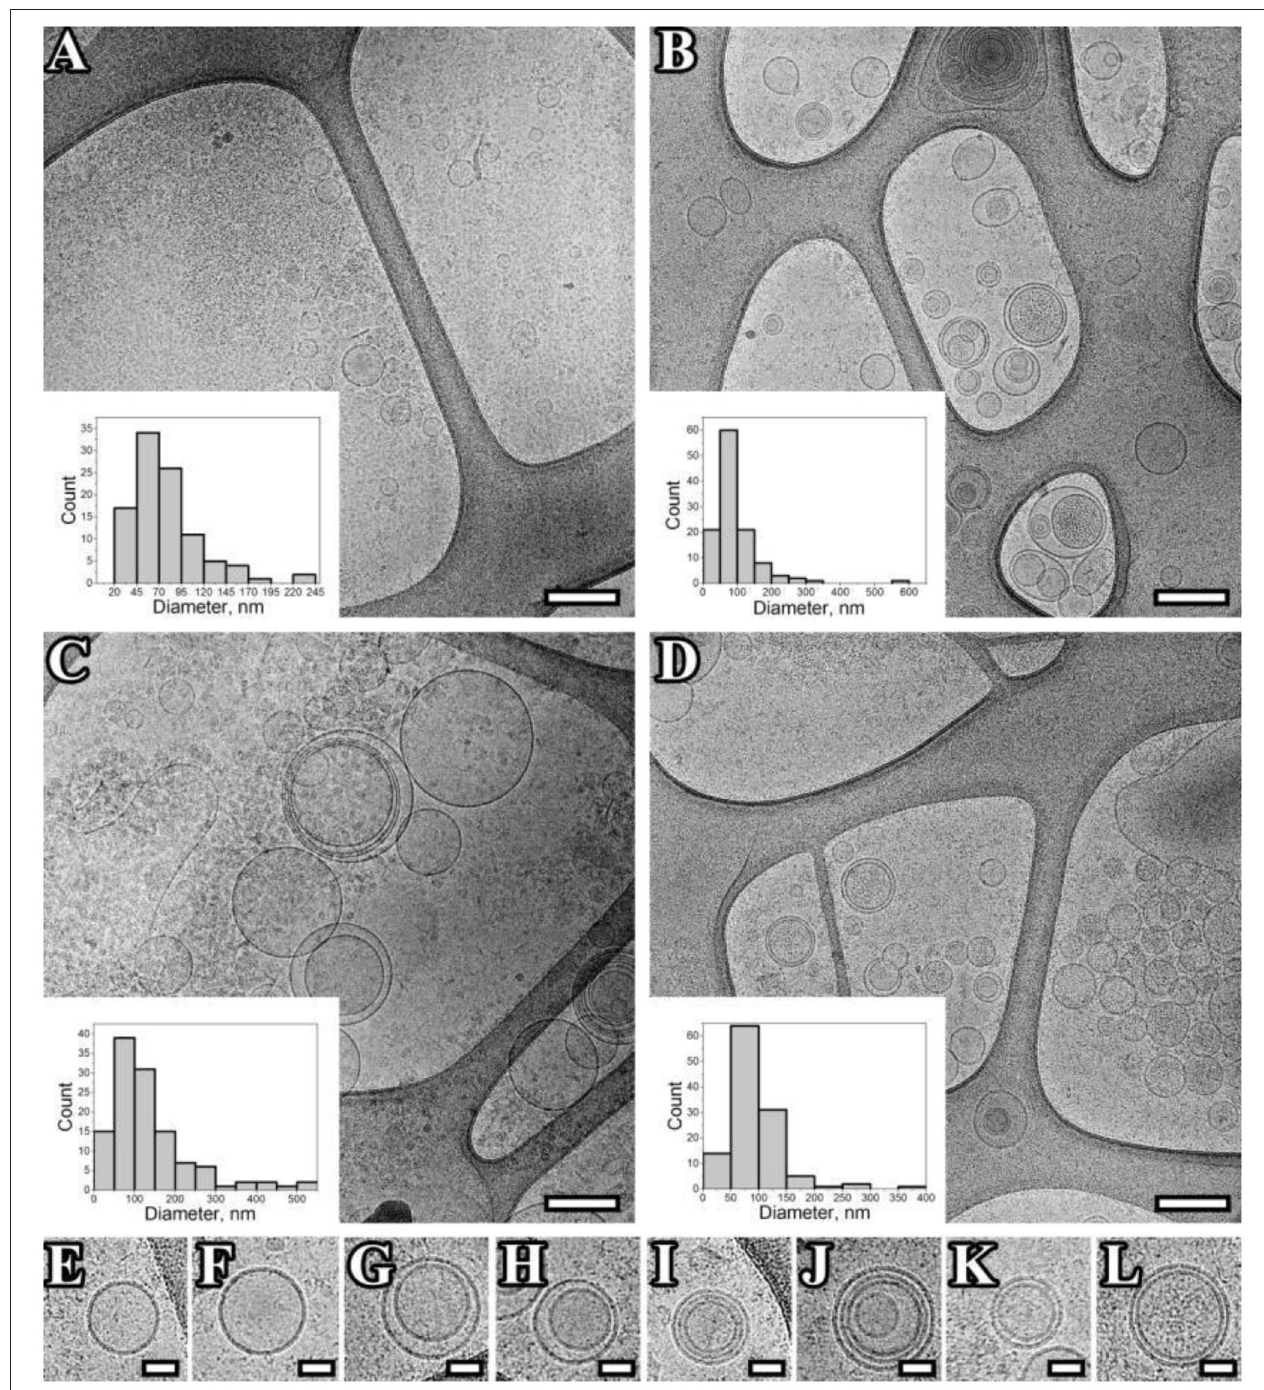
FIGURE 1 | Representation of exosomes with various morphology. (A–L) , Cryo-EM images of exosomes isolated from pooled samples of plasma of HFs (A) , total blood of HFs (B) , plasma of BCPs (C) , total blood of BCPs (D) , single vesicles (E,F) , double vesicles (G,H) , multilayer vesicles (I,J) , double-membrane vesicles (I–K) , vesicles with electron dense cargo in lumen (G,L) . Scale bars are 500nm for micrographs (A–D) , and 100nm for micrographs (E–L) .